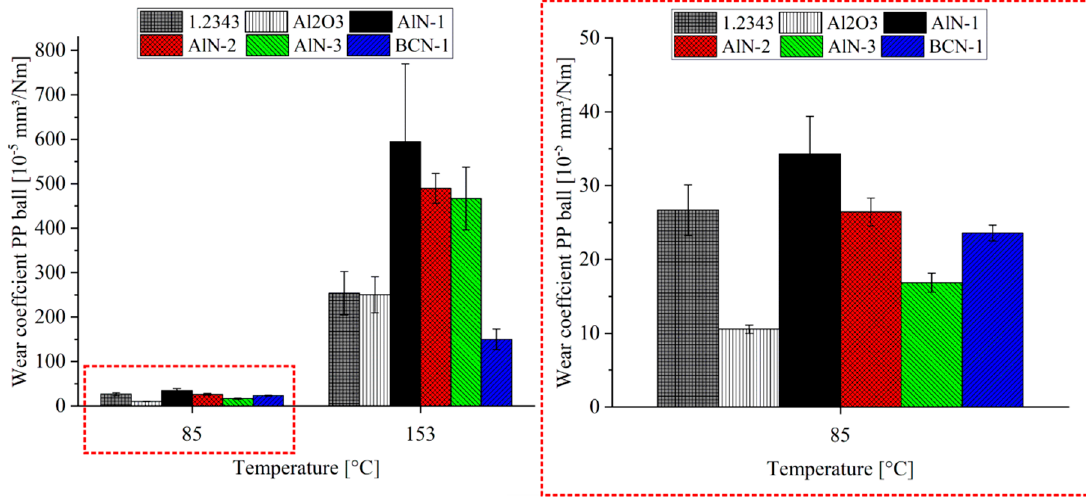
Figure 5. Wear coefficient of the PP counter balls after the sliding against the AlN-1, AlN-2, AlN-3,